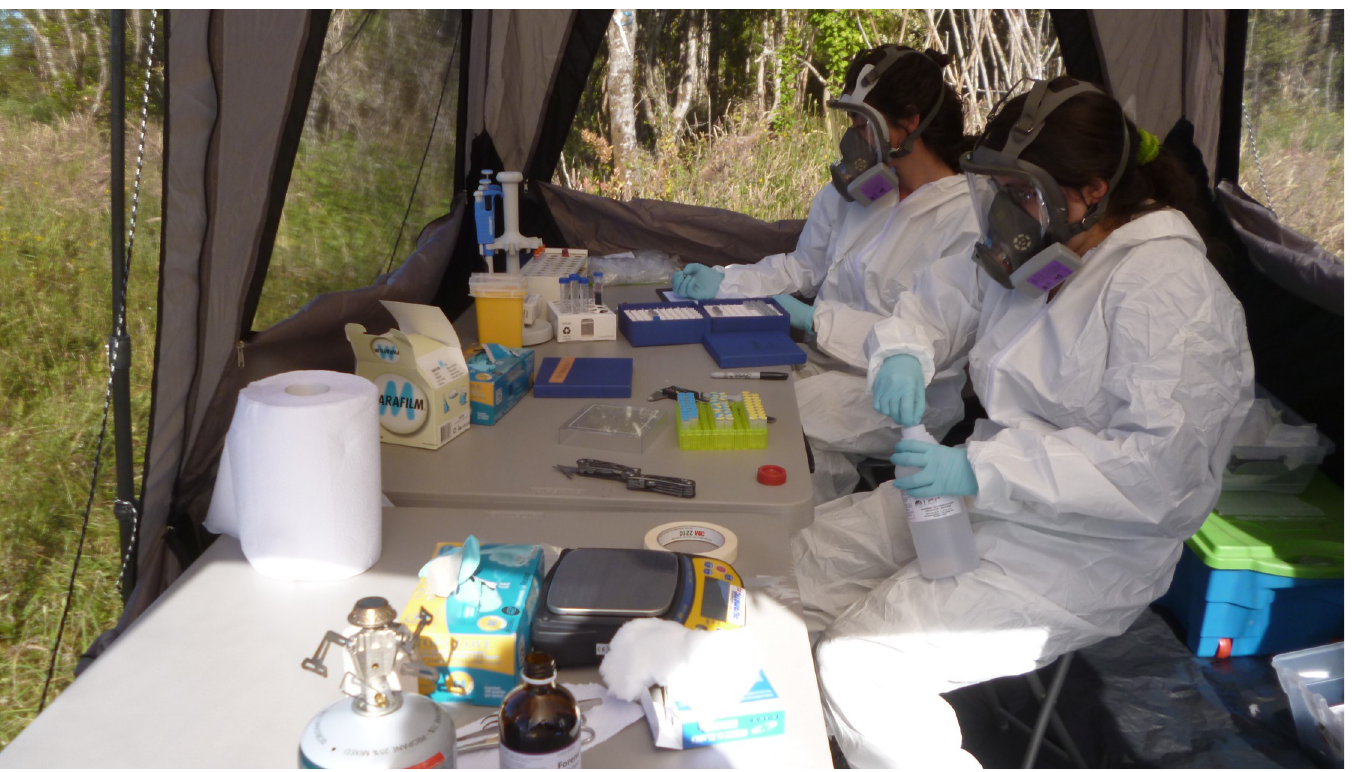
Fig 2. Central processing tent installed at each sampling site. Biosafety conditions during rodent handling were adapted to the risk of hantavirus cardiopulmonary